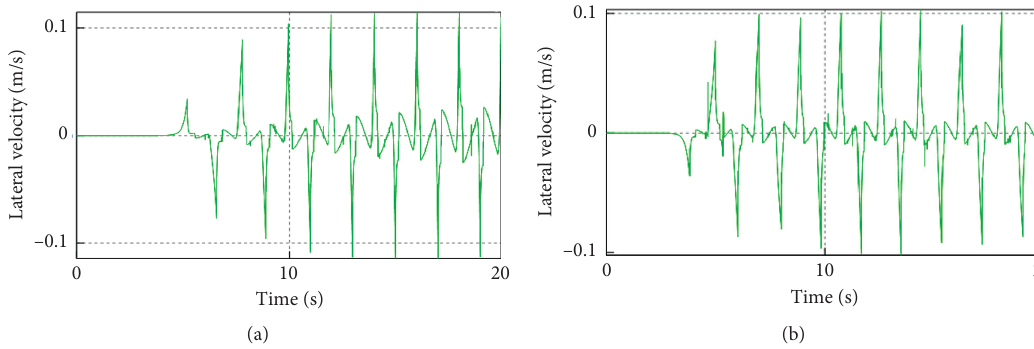
Figure 10: Change in the lateral velocity under different driving wheel treads. (a) 374mm. (b) 574mm.